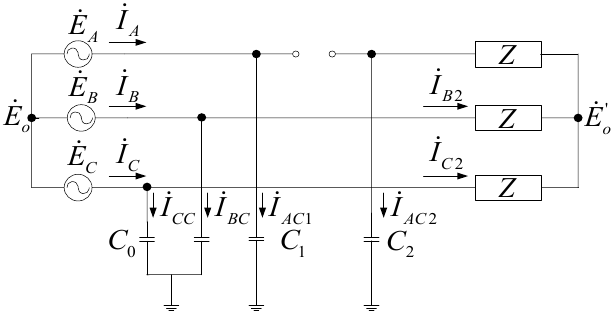
Figure 10. Equivalent circuit of ungrounded single-phase wire